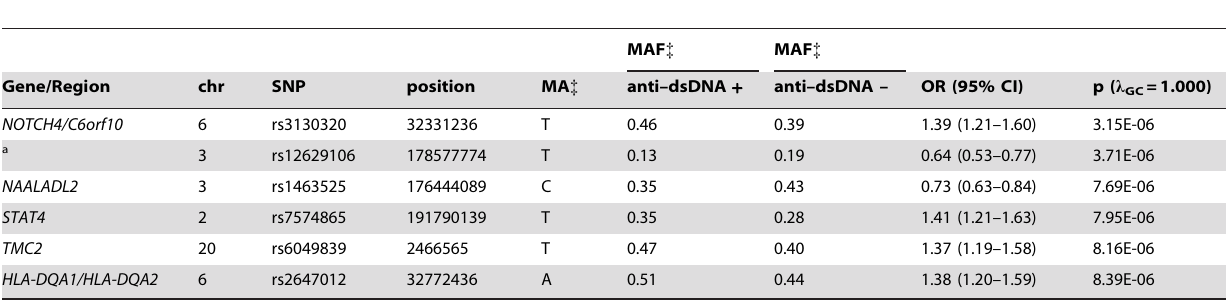
Table 4. Loci with suggestive (p between 5E-07 and 1E-05) evidence for association with anti–dsDNA + SLE identified in the